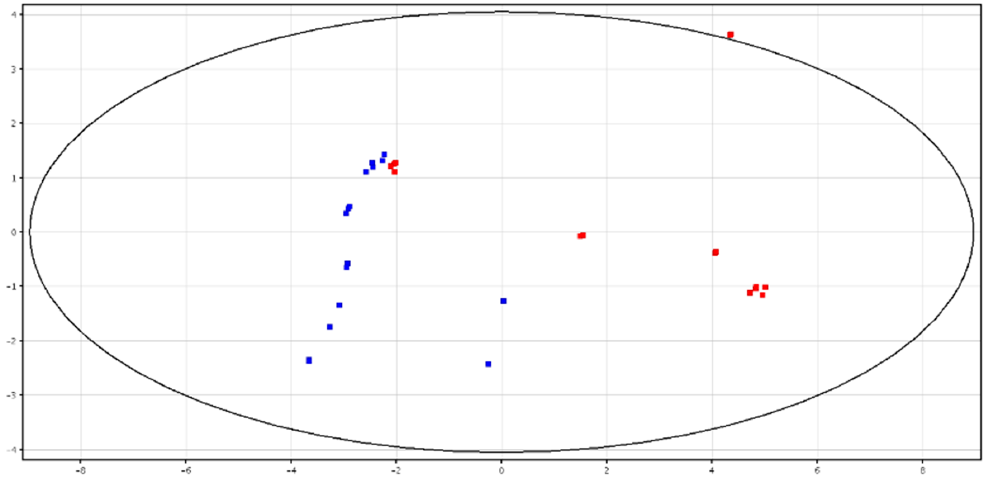
Figure 5. PCA scores plots of the LC–MS data acquired from fresh spermatozoa for high (in red) and low (in blue) fertility bulls. PC1 ( x -axis) is 54.94%; PC2 ( y -axis) is 13.29%.